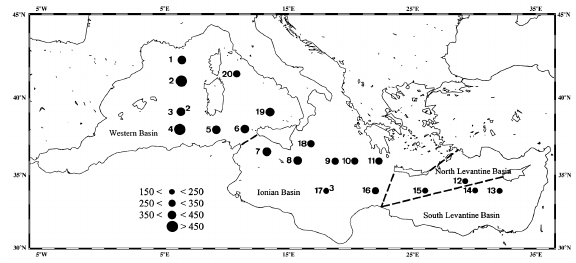
Fig.8. Integratedprimaryproduction (mg C m − 2 day − 1 )duringtheMINOScruise(May-June 1996). Repro- Fig. 8. Integrated primary production (mgCm − 2 day − 1 ) during duced with permission from Moutin and Raimbault (2002). the MINOS cruise (May–June 1996). Reproduced with permission from Moutin and Raimbault